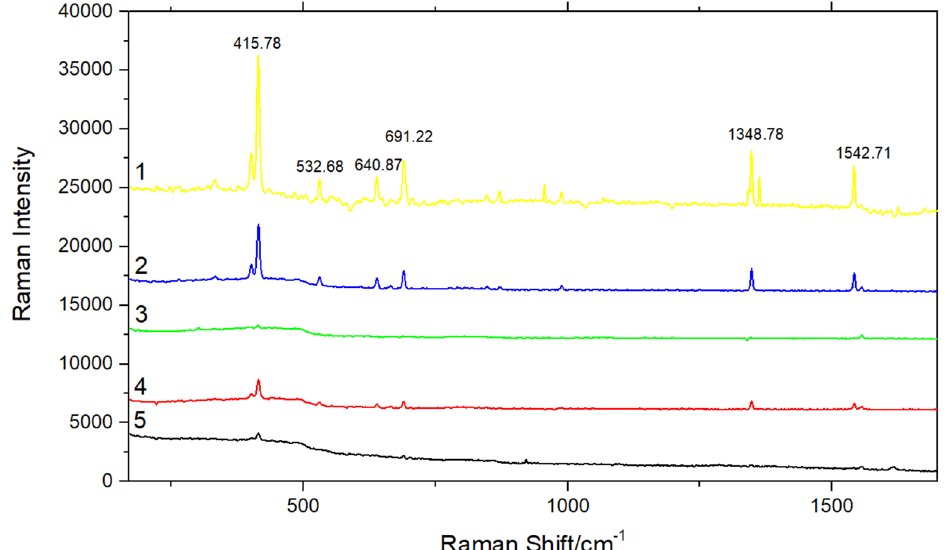
Figure 7. SERS signal of phenanthrene obtained on Fe 3 O 4 @PDA@Au@GO, Fe 3 O 4 @PDA@Au, Fe 3 O 4 @PDA and Fe 3 O 4 , respectively (1) Fe 3 O 4 @PDA@Au@GO substrate; (2) Fe 3 O 4 @PDA@Au